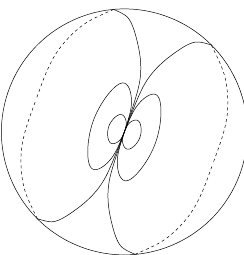
Figure 4: A flow on S 2 with a single index 2